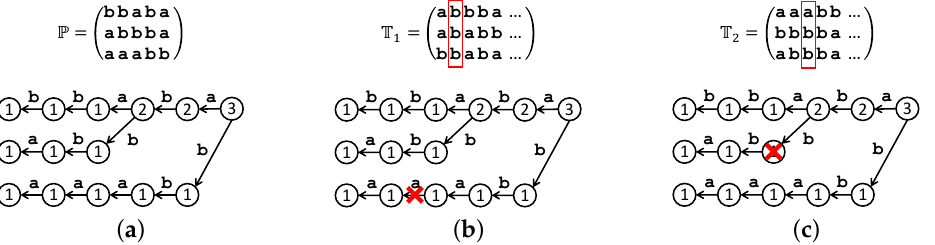
Figure 3. ( a ) Track trie of P = ( bbaba , abbba , aaabb ) ; ( b ) example of mismatch when the track trie cannot find the transition; ( c ) example of mismatch when the number of tracks is more than the weight of the node.